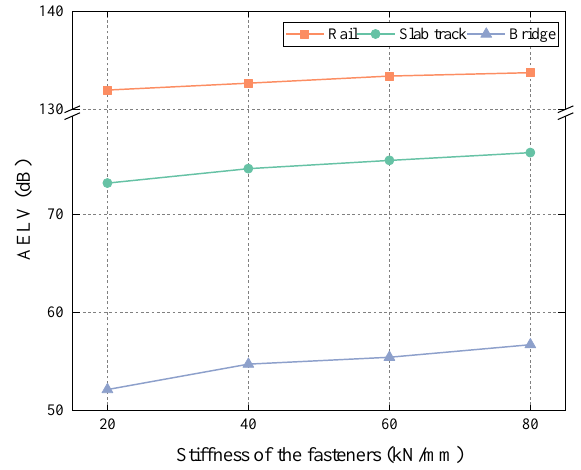
Figure 14. The AELVs of the track–bridge Figure 12. The AELVs of the track – bridge system.